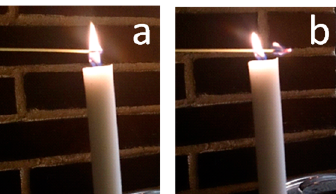
Figure 1. A stick of spaghetti being carbonized from combustion. ( a ) Stick of spaghetti being ignited in a candle flame; ( b ) the stick lies outside the flame and undergoes self-combustion.